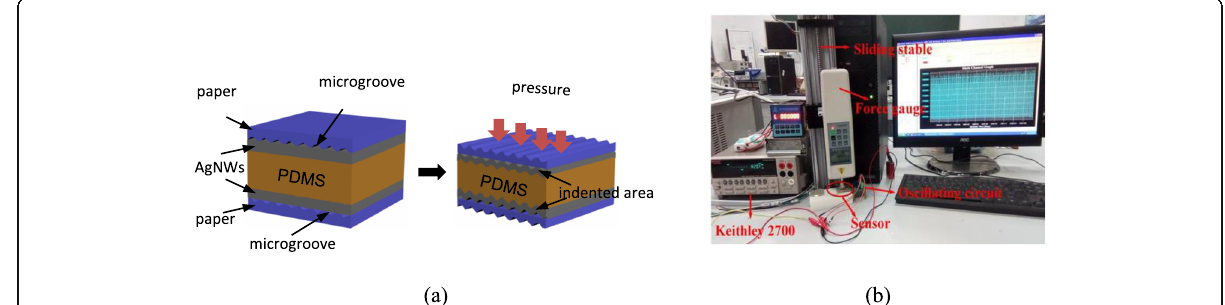
Fig. 1 a Structure of AgNW-paper-based capacitive FPS and simplified mechanism. b Test platform for capacitive